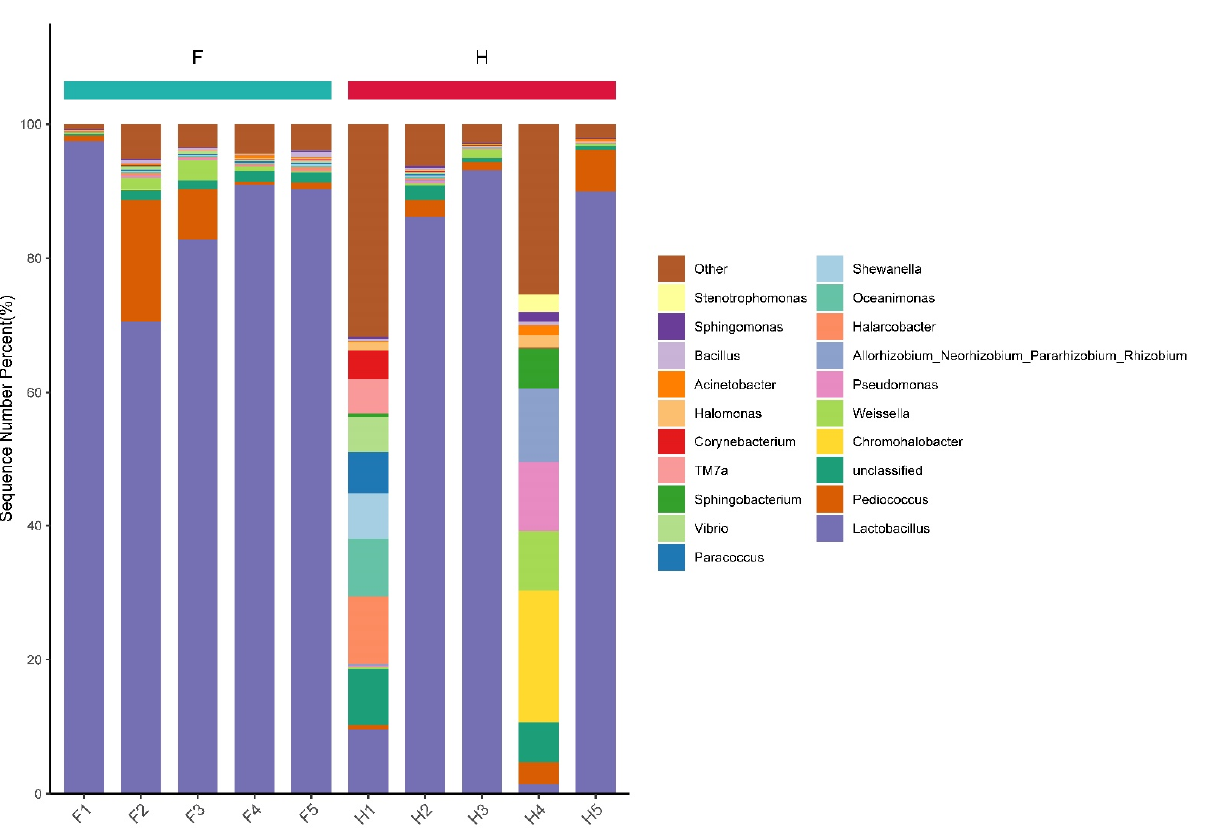
Figure 7. Proportion of different bacteria in samples at the genus level. F means factory production; H means household handmade.